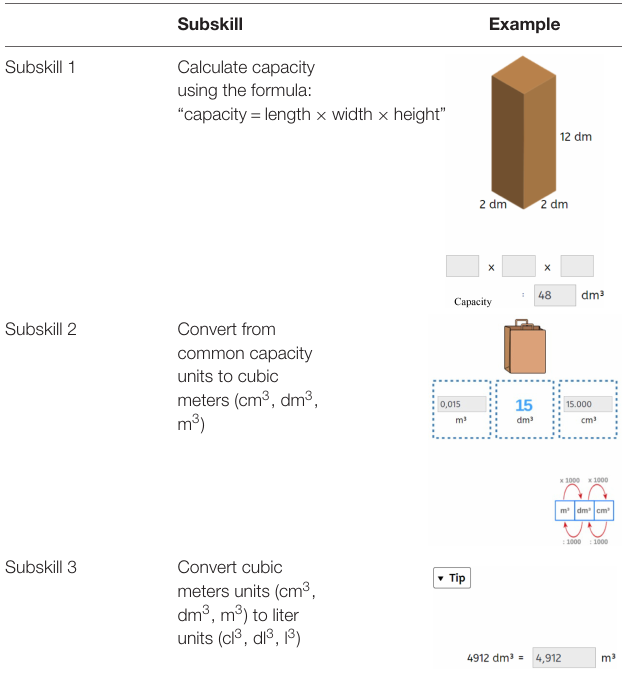
TABLE 1 | Examples of problems for each